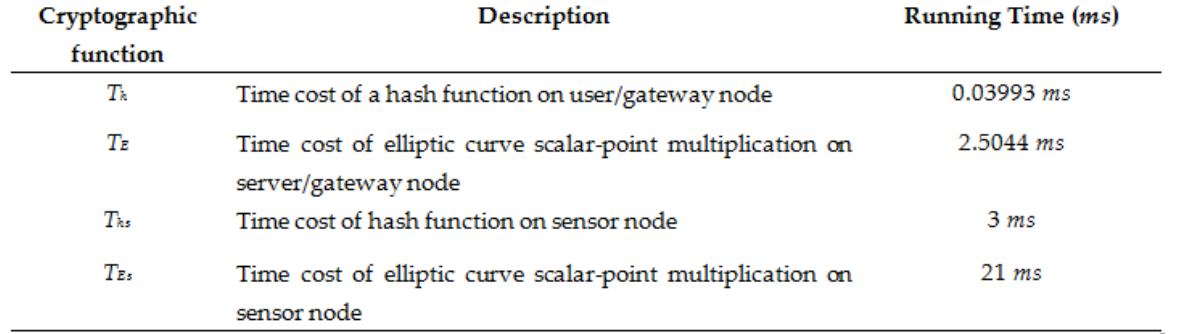
Figure 10. Cryptographic function and their description for computation cost. Figure 2. Comparison of computation cost .